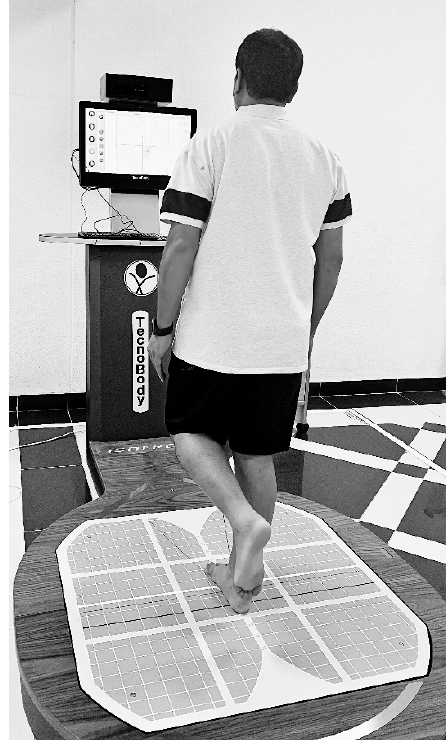
Figure 2. Assessment of postural control using stabilometric force platform.